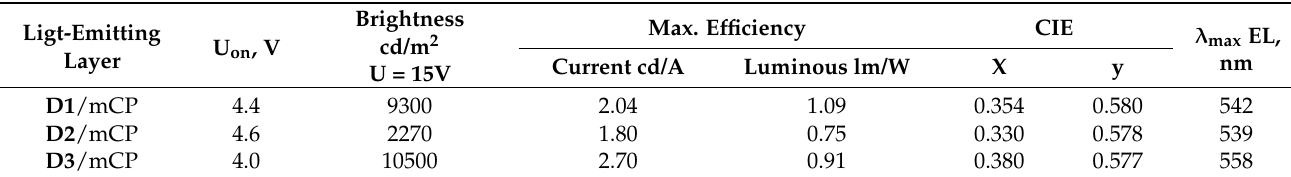
Table 3. EL characteristics of the studied OLEDs with different light-emitting